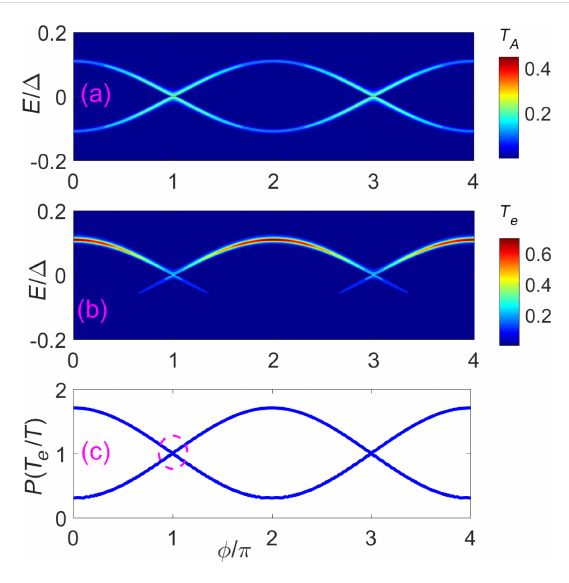
Figure 4: Two STM leads (or weak coupled normal leads) localized at the junction can read the putative 4 π period through the differential conductance. (a) Contour plot of the Andreev reflection coefficient T A of a STM lead as a function of the flux and the incident energy E . (b) Contour plot of the electron tunneling coefficient T e from the STM lead 1 to the STM lead 2 as function of the flux and the incident energy E . (c) The ratio between the peak value of T e and the peak value of T , here T = ( T e + T A )/2. They show similar information of the DOS (see Figure 1c). The DOS of one energy spectrum exhibits a 4 π period. However, when both spectra are considered, the period returns to 2 π . In this situation, we can distinguish by the even–odd cross point as indicated by dashed circle. The parameters are N x = 200 a , μ = − 2 t , and V x = 2 Δ .